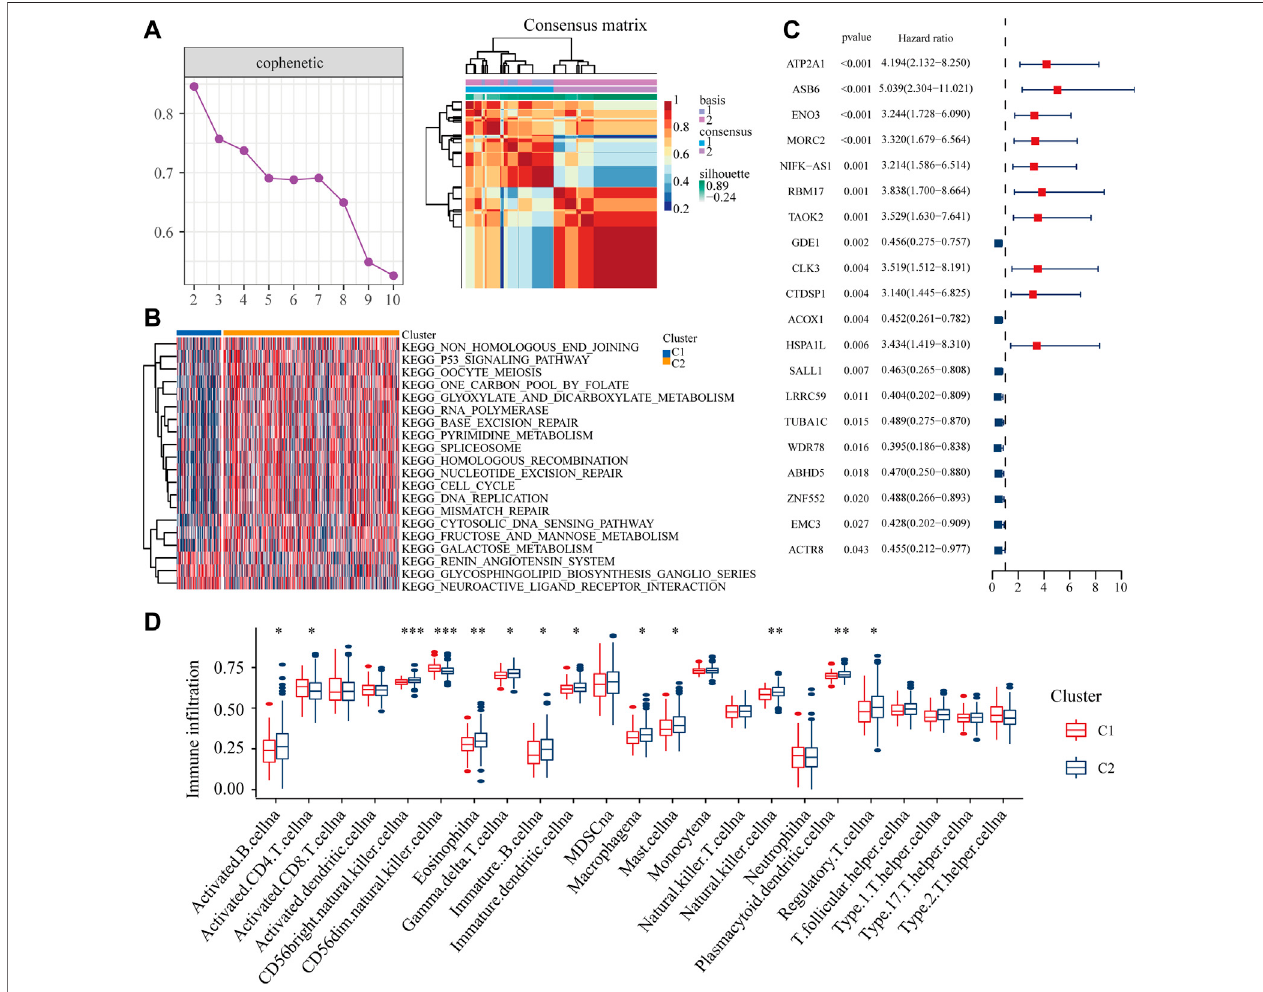
FIGURE3| Distributionofm 7 G related DDR gene (A) NMF clustering based onm 7 Grelated DDR genedecomposes the samples inTCGA cohorts. (B) TheGSVA analysis of two clusters. (C) The independent prognostic analysis of the DEGs from two clusters. (D) The ssGSEA analysis of two clusters.